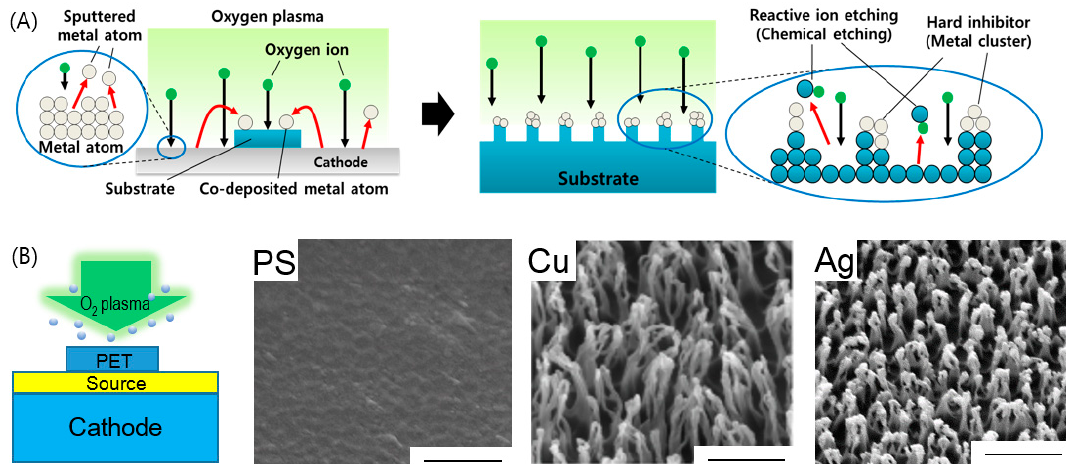
Figure 2. ( A ) A schematic for pattern formation during the preferential etching on the polymer under oxygen plasma treatment; ( B ) A schematic of the experiment material co-deposition on the PET covered on the cathode in 30 min with different sources, included PS designed to show induce, Ag, Cu. The scale bars represent 500 nm. Reprinted with permission from [32]. Copyright 2014 Wiley.